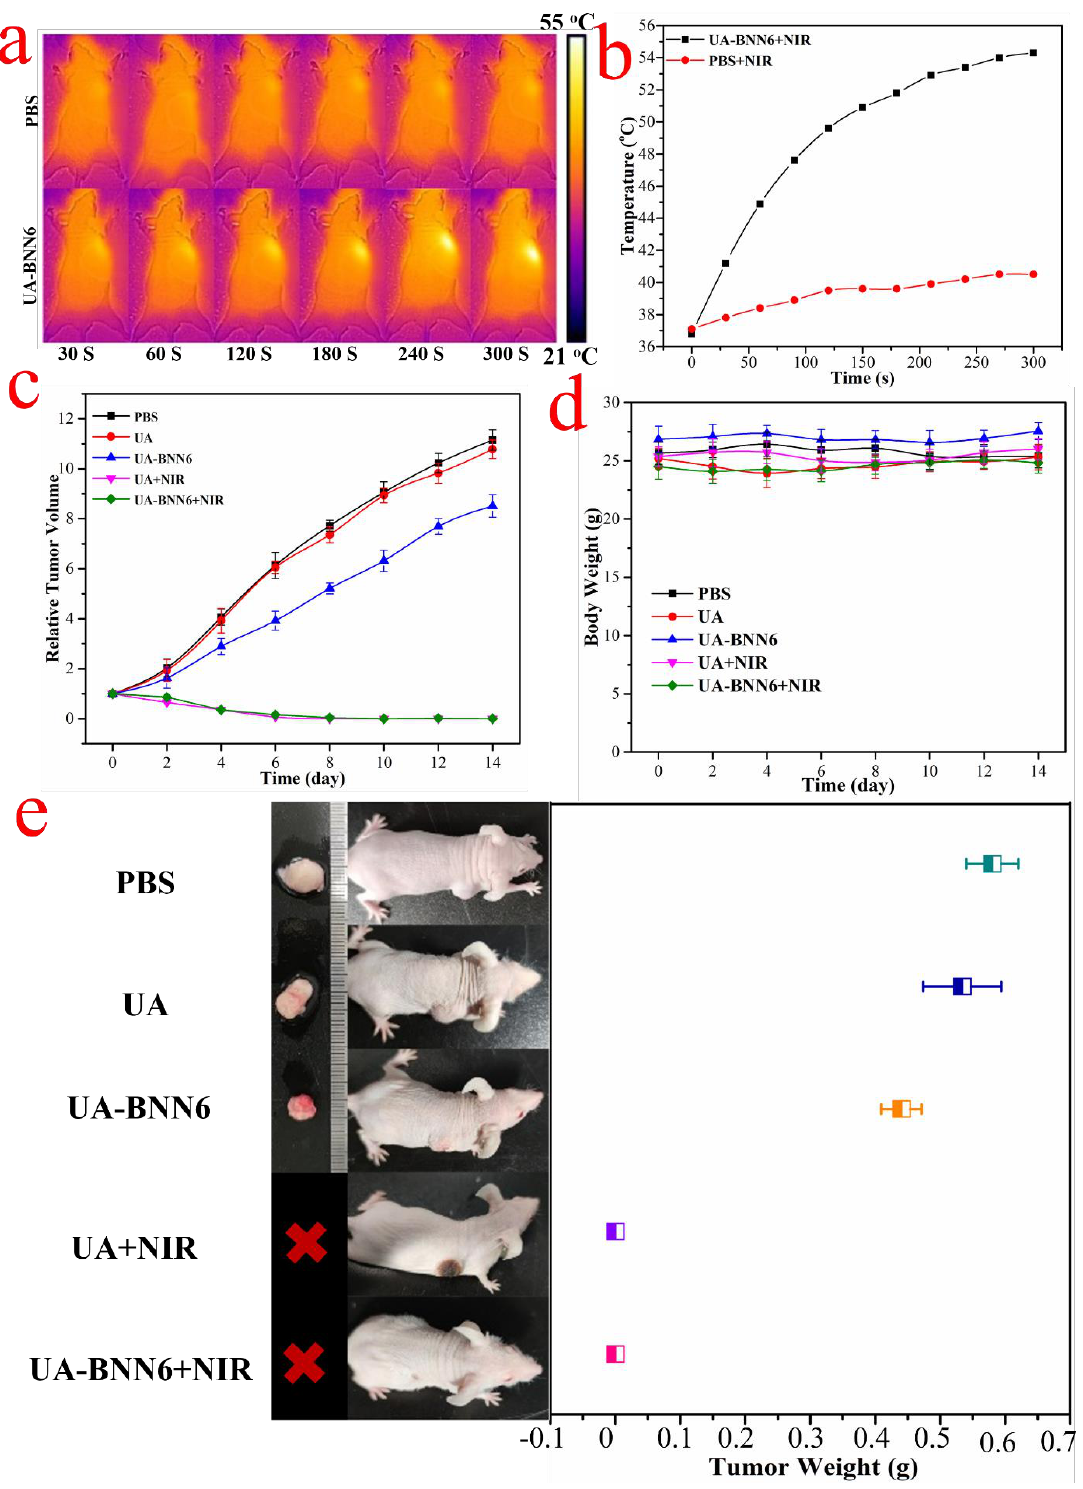
Figure 7. NO-photothermal synergistic tumor therapy in vivo. ( a ) Photothermal imaging of nude mice 6 h after injection of PBS or UA-BNN6 and 808 nm NIR laser treatment and ( b ) temperature change curve of tumor site; ( c ) changes of tumor volume in nude mice during different treatments; ( d ) changes in body weight of nude mice during treatment; ( e ) photographs of nude mice and tumors after different treatments (left), and the weight of removed tumors (right).